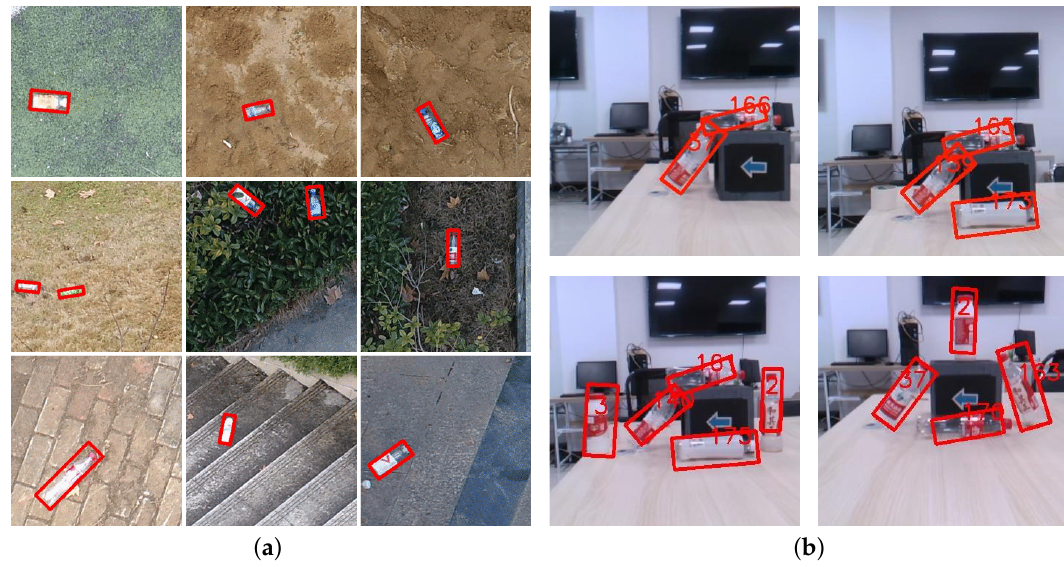
Figure 1. ( a ) Sample images in Unmanned Aerial Vehicle (UAV)-Bottle Detection (BD) dataset with plastic bottle groundtruth labeled by red box. ( b ) Detection results of Rotation-SqueezeDet with 2D box and rotation angle of multiple objects at the same time. Oriented angles of bottles are shown in the